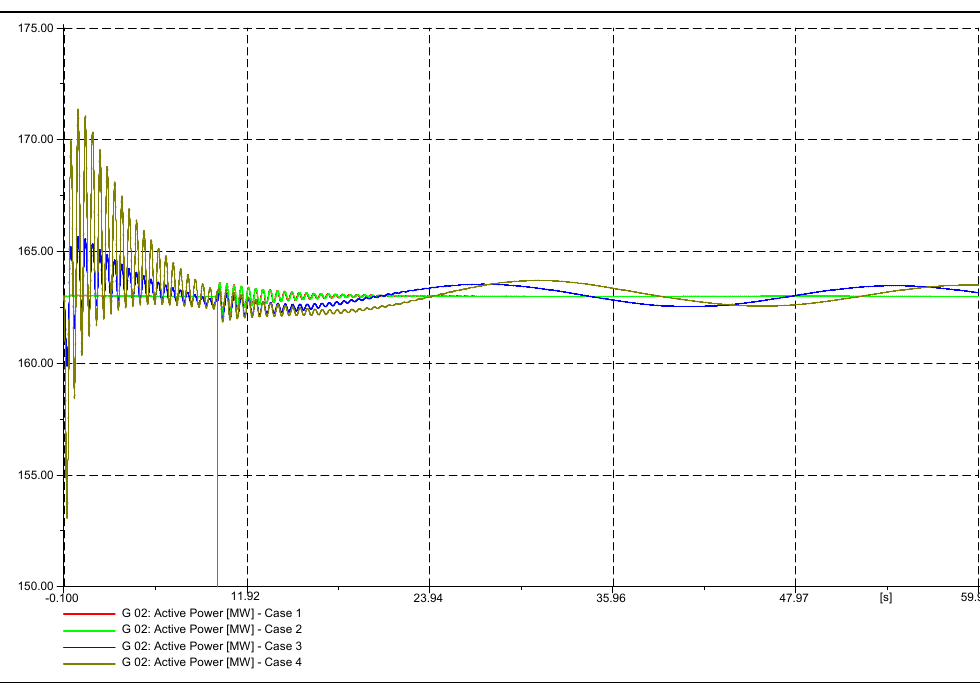
Figure 8. Active power for Machine 2 in the first